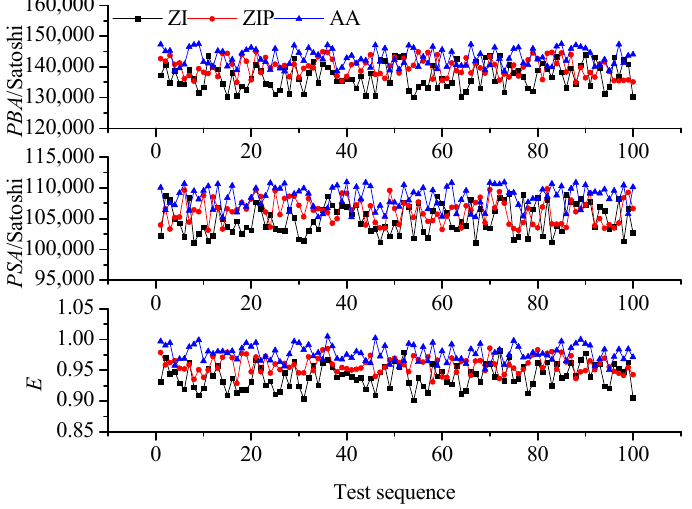
Figure 9. PBA , PSA , and E of different trading strategies.